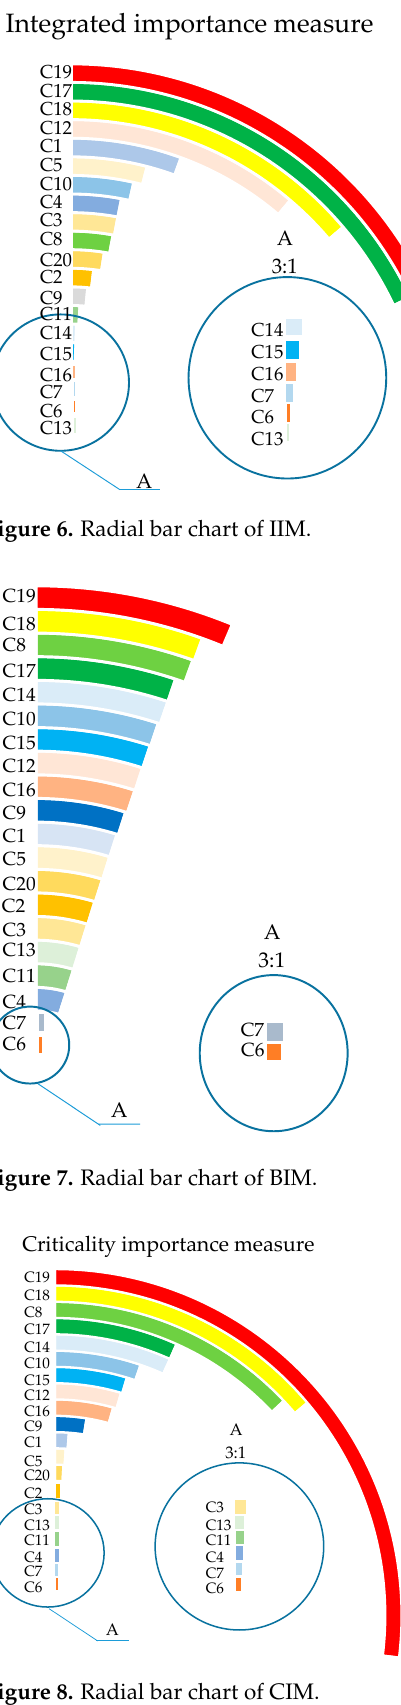
Figure 9. Radial bar chart of FVIM. From these radial bar charts, the IM rankings can be clearly displayed, making it con- venient to determine the key fault causes of shearer-cutting units. Figure 6 shows that these four bottom events with the greatest IIM (the top 20% of IIM ranking) are C19 (bear- ing wea r ), C17 (nonconformity of oil varieties or improper oil quantity), C18 (cooling spray function failure), and C12 (bolt fracture). Figures 7 and 8 show that the ranking of BIM is the same as that of CIM. The four bottom events with the highest BIM or CIM are C19 (bearing wear), C18 (cooling spray function failure), C8 (short circuit between coils, water in connection cavity, dampened circuit), and C17 (nonconformity of oil varieties or improper oil quantity). Figure 9 shows that the four bottom events with the highest im- portance of FVIM are fatigue damage, C15 (fatigue damage, gearbox dry friction or parti- cle contamination), C19 (bearing wear), C18 (cooling spray function failure), and C8 (short circuit between coils, water in connection cavity, dampened circuit). Therefore, we can easily find the rankings of different IMs by r adial bar charts . From the perspective of the relative importance distribution of four importance measures, in Figure 7, except for C6 (oil seal leakage) and C7 (oil spill blockage), the BIM ranking of other bottom events is very close, and the ranking results of BIM cannot be intuitively distinguished. Comparing Figures 7 and 8, the ranking results of BIM and CIM